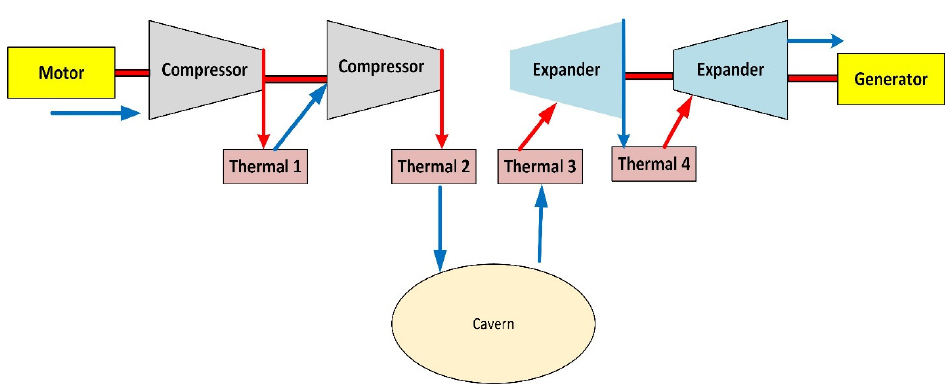
Figure 13. Working principle of compressed air energy storage systems [142].